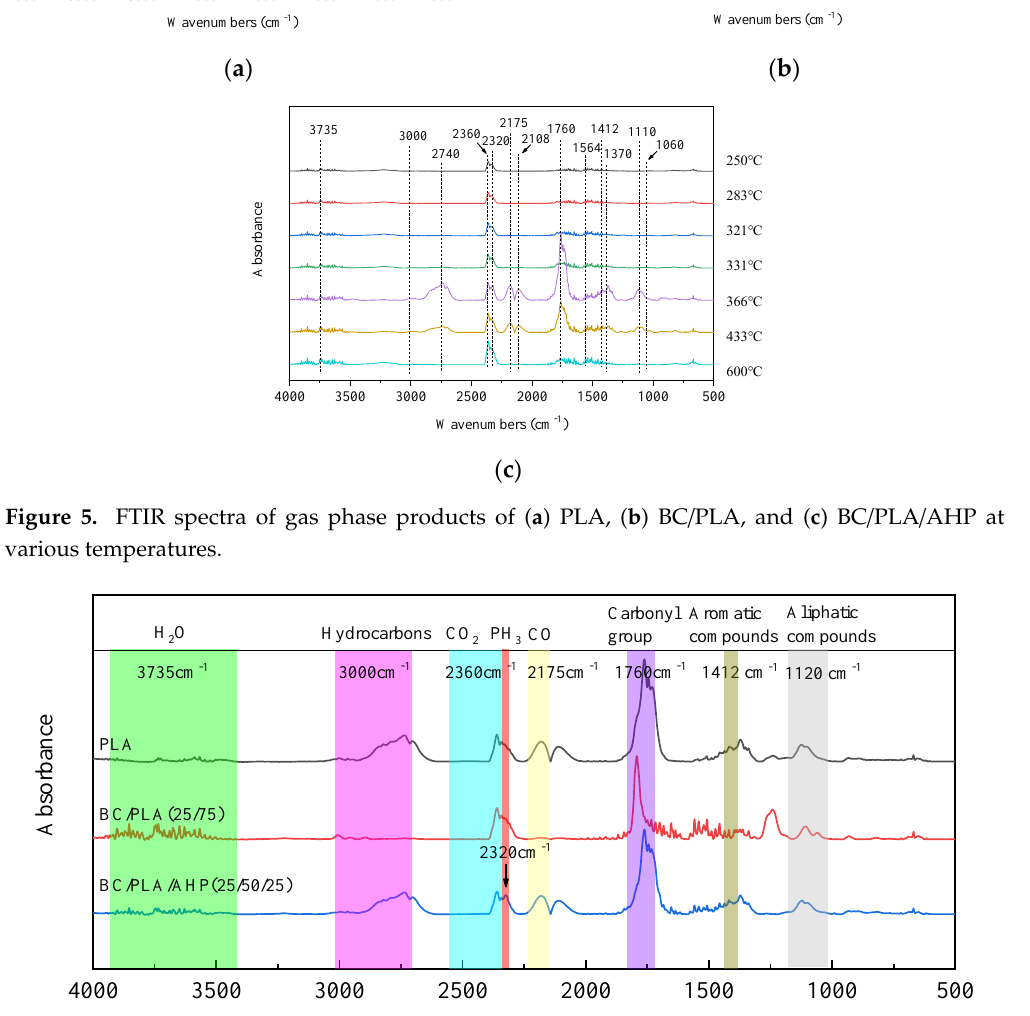
Figure 6. FTIR spectra of gaseous products for the thermal decomposition of PLA, BC / PLA 25 / 75, and BC / PLA / AHP 25 / 50 / 25 composites at T max .